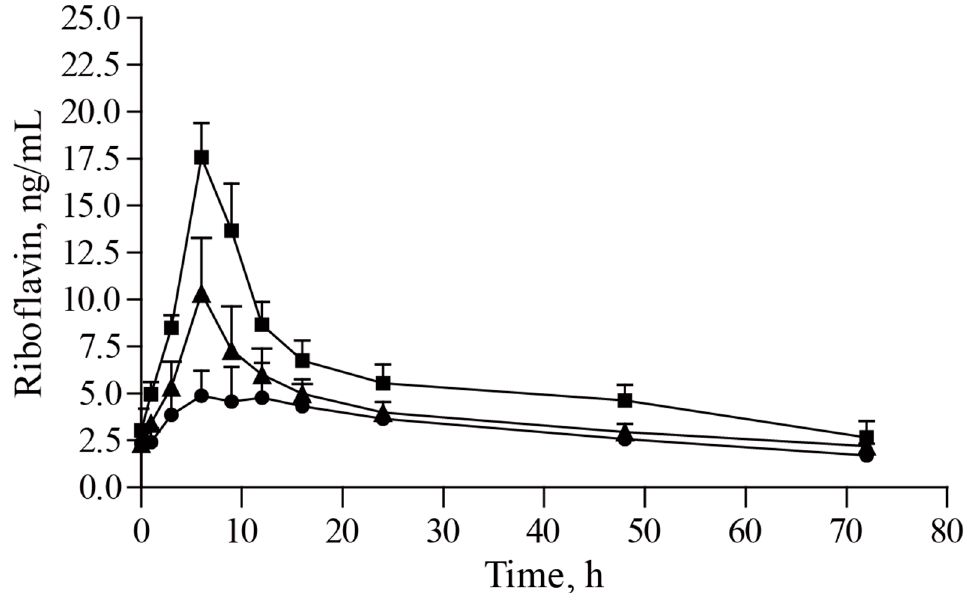
Figure 6. The plasma concentration of riboflavin versus time. The concentration of riboflavin in plasma from 0 to 72 h after oral placebo ( ● ), non-microencapsulated vitamin supplement ( ▪ ), and microencapsulated vitamin supplement ( ▲ ), respectively. Error bars represent standard devia- tions.